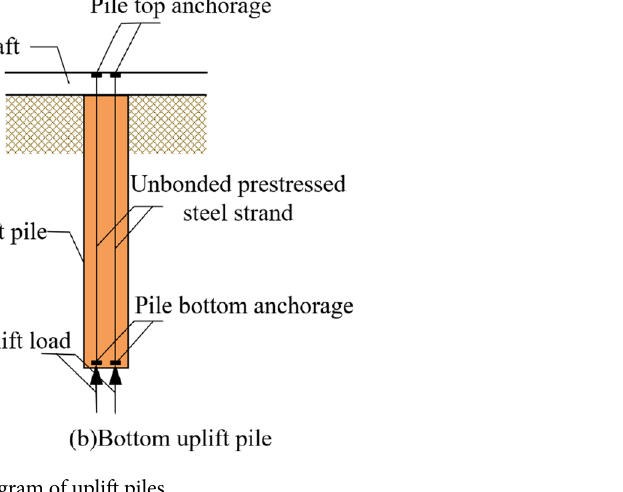
Figure 1. Schematic diagram of uplift